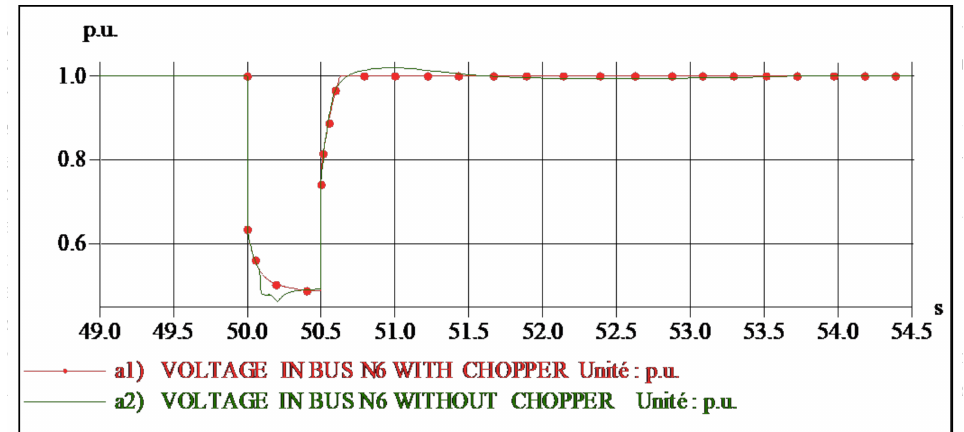
Figure 11. Variation of voltage in busbar N6 with and without a